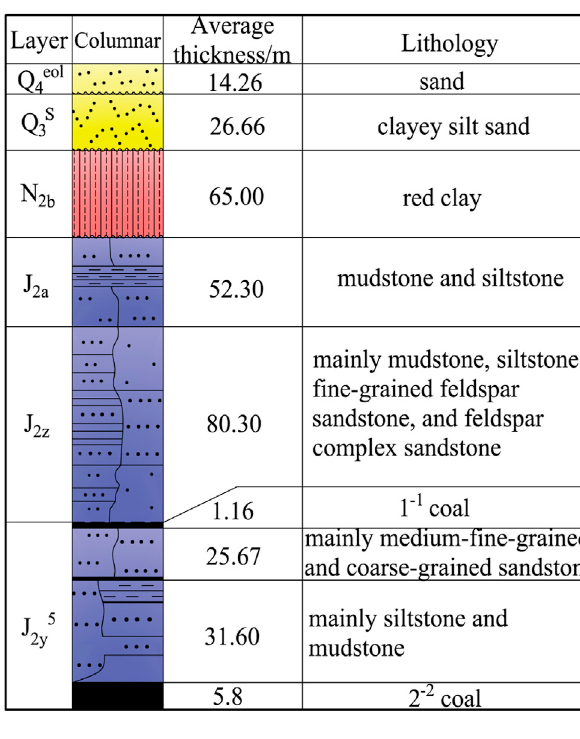
FIGURE 3 | Comprehensive bar chart of the stratigraphy of the study site.